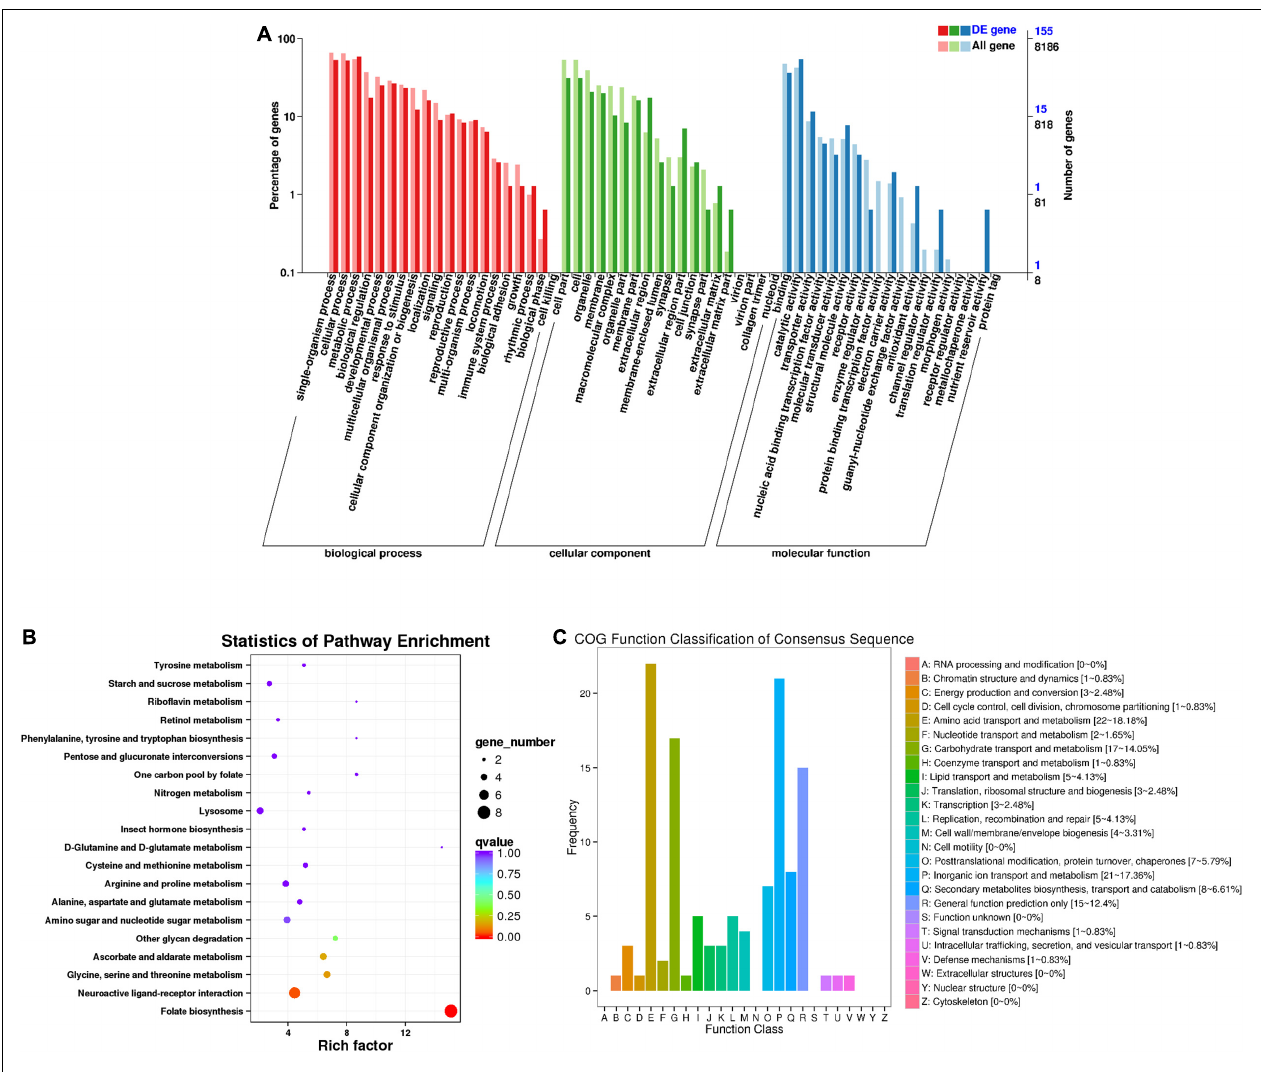
FIGURE 4 | Female differentially expressed gene analysis. (A) Annotated statistical graph of GO secondary nodes. Light colors represent all genes and dark colors represent all differentially expressed genes in females. (B) Scatter plot of enriched KEGG pathways. Each circle in the graph represents the number of genes enriched for a specific KEGG pathway. Enrichment factors represent the ratio of the number of differentially expressed genes to all the genes in the pathway. (C) COG annotation classification statistics of differentially expressed genes in females. (B) Frequency is the number of